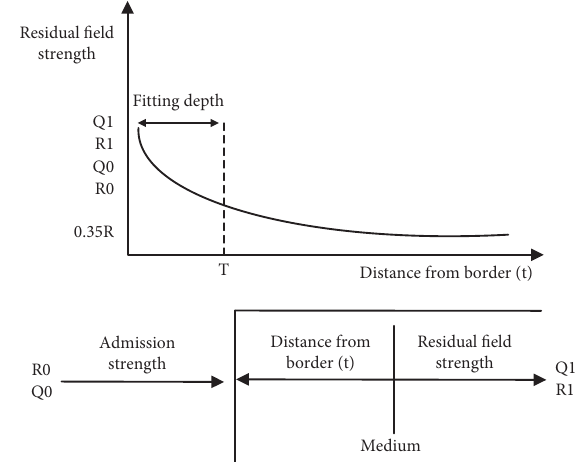
Figure 2: The electromagnetic wave decays exponentially through the